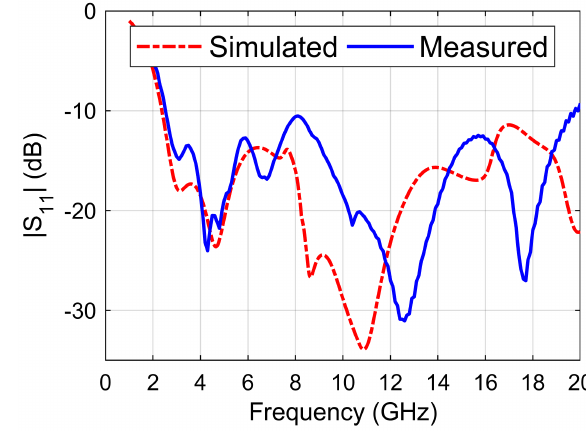
FIGURE 10. Simulated and measured |S 11 | of the proposed CPW-fed